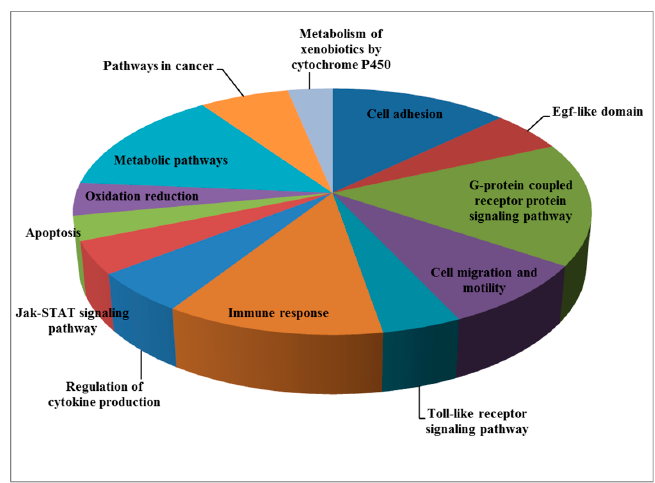
Figure 3. Signaling pathways altered in LS. The pie chart illustrates the signaling pathways that were differentially represented in LS cells as a percentage of the total number of differentially expressed